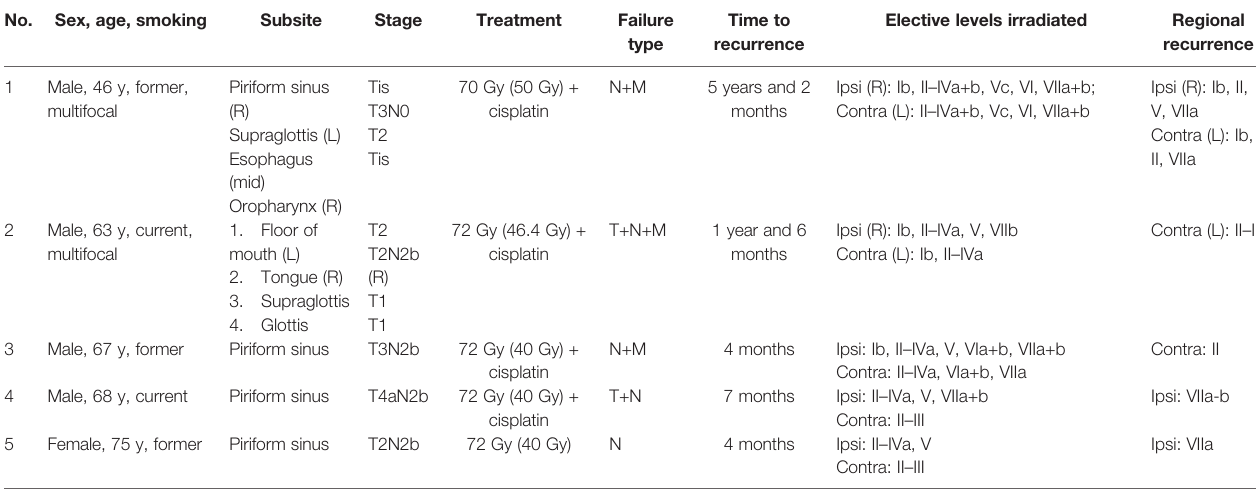
TABLE 3 | Demographics of patients with regional recurrence outside